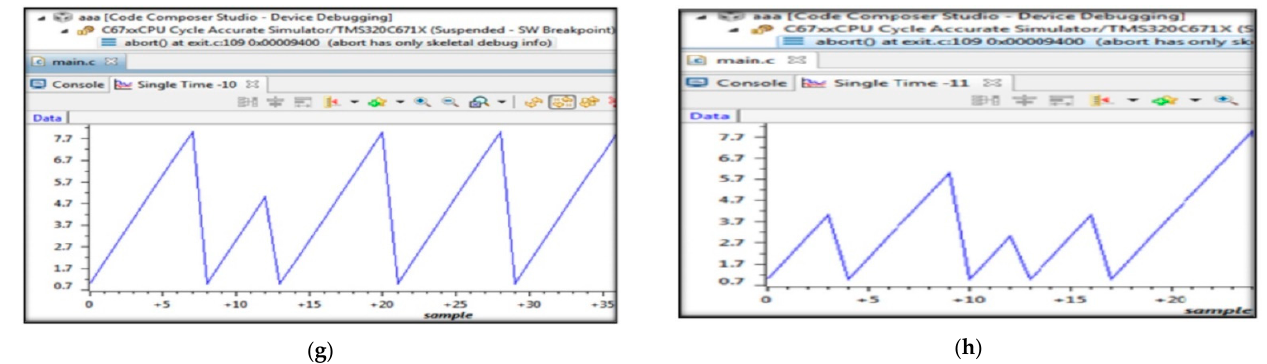
Figure 16. Simulations in code composer studio. ( a ) Normal communication (Tx to Rx), ( b ) delay Tx (at the beginning), delay Rx (at the beginning), ( c ) delay Tx (in between), delay Rx (in between), ( d ) delay Tx (both (( b ) and ( c ) cases)), delay Rx (both (( b ) and ( c ) cases)). ( e ) No data received at Rx. ( f ) No data transmitted from Tx. ( g ) Data overriding. ( h ) No synchronization.